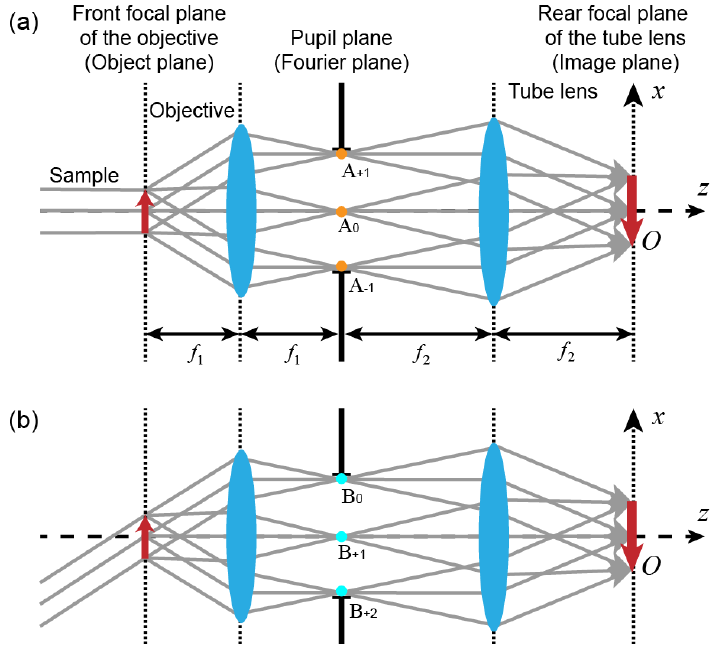
Figure 2. The illustration of diffraction orders according to ( a ) the axial illumination, and ( b ) the largest-angle oblique illumination.